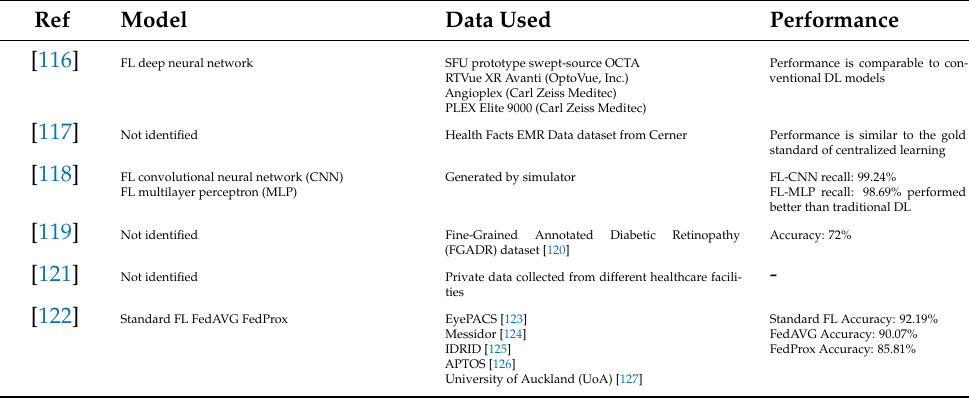
Table 5. Federated machine learning implementations in diabetes